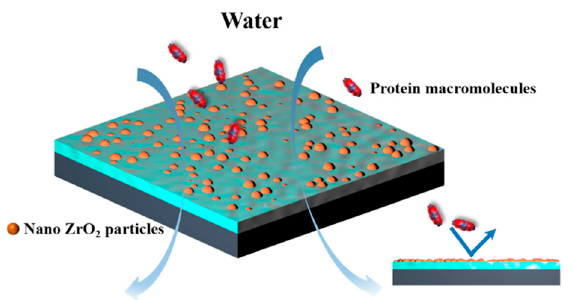
Figure 4. Schematic diagram of ZrO 2 /BCM resistance to contaminant .